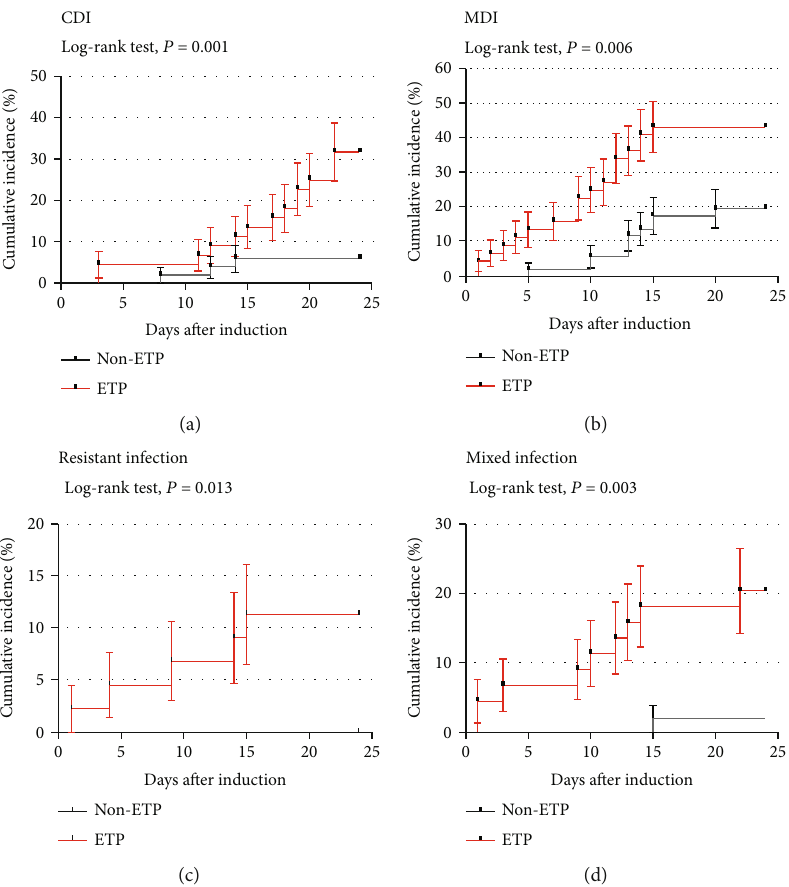
Figure 3: Kaplan-Meier analysis of induction-related infections in the ETP and non-ETP